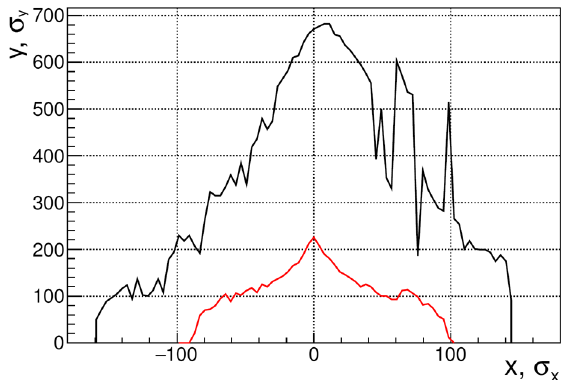
FIG. 17. Dynamic aperture degradation for FCC-ee interaction region variant 3, black is with crab sextupole OFF, red with crab sextupole ON, includes only nonlinearities of the interaction region, on